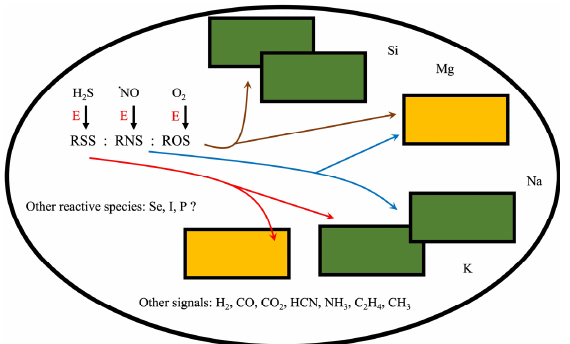
Figure 1. Schematic representation of a prebiotic supramolecular complex that processes energy and matter [1]. The different components represented by the colored rectangles carried out specialized functions and interacted with each other coordinating through energy signals (redoxtasis) and chemical signals created by metabolites. It is possible that the RSS:RNS ratio, and later the RSS:RNS:ROS ratio, modified the redox homeostasis of the prebiotic system, modified internal sig- nals, and caused changes in the nucleic acids, proteins, peptides, and other organic molecules of the prebiotic supramolecular complexes [12,13]. E: energy; RSS: reactive sulfur species; RNS: reactive nitrogen species; ROS: reactive oxygen species.